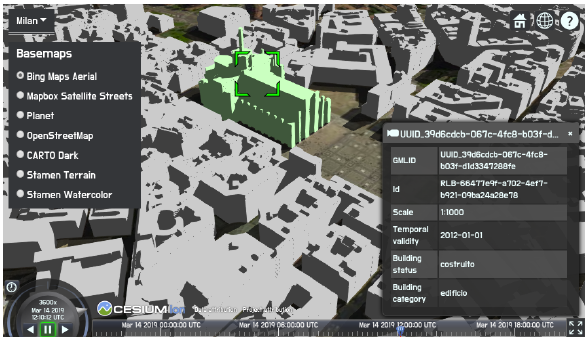
Figure 1. Visualization and query of Milan Cathedral